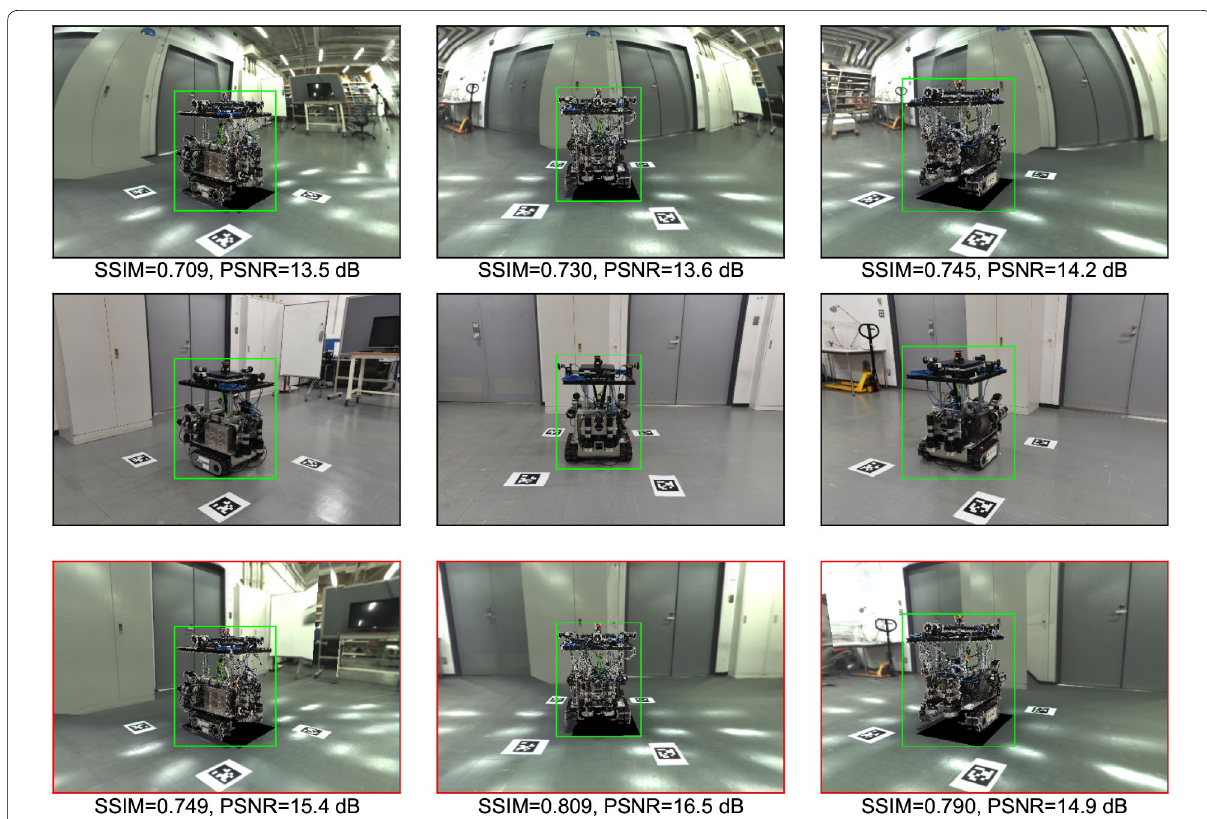
Fig. 11 Free viewpoint images from various viewpoints. From the first row to the last row: images generated by the previous method [7], images taken from outside of the robot, and images generated by the proposed method. The values written below the first and last rows are the SSIM index and the PSNR, which were calculated using images of the second row as reference images. The green rectangle in each image represents the robot-body region, which was masked out before evaluation